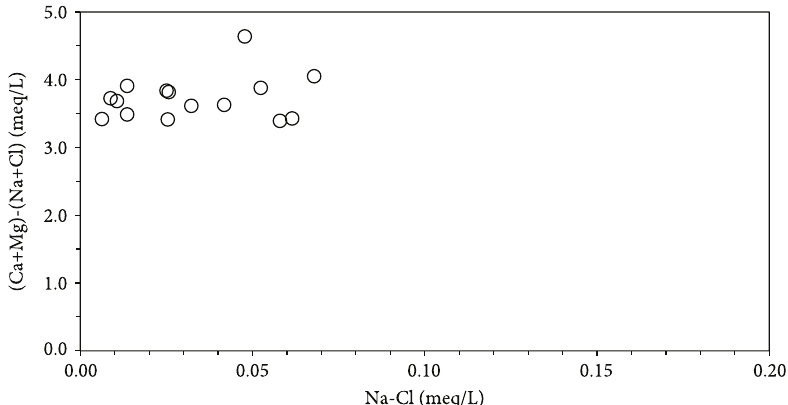
– +SO 42 − )] vs. (Na + -Cl − ). The investigated water samples are not correlated highlighting that the ion Figure 8: [(Ca 2+ +Mg 2+ )-(HCO 3 exchange process does not take